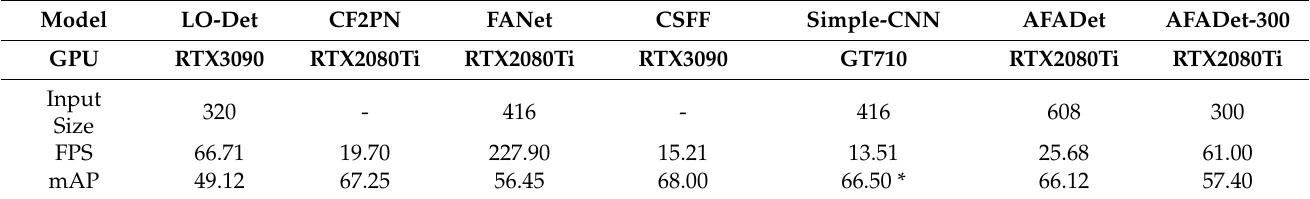
Table 2. Comprehensive comparison of detection speed and accuracy.